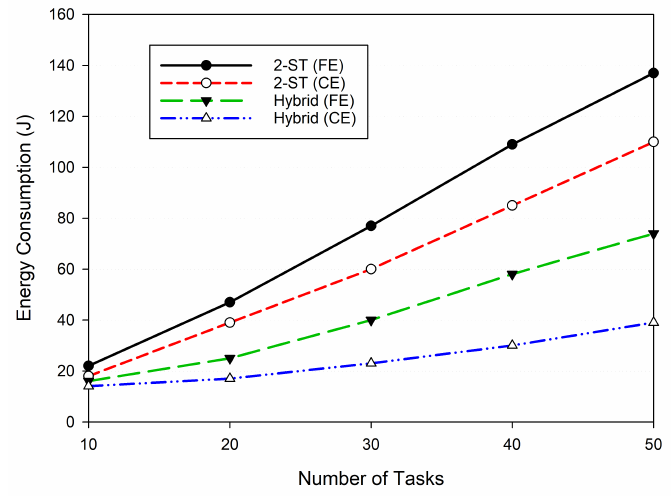
Figure 5. Energy consumption in J for different tasks within the smart home environment.